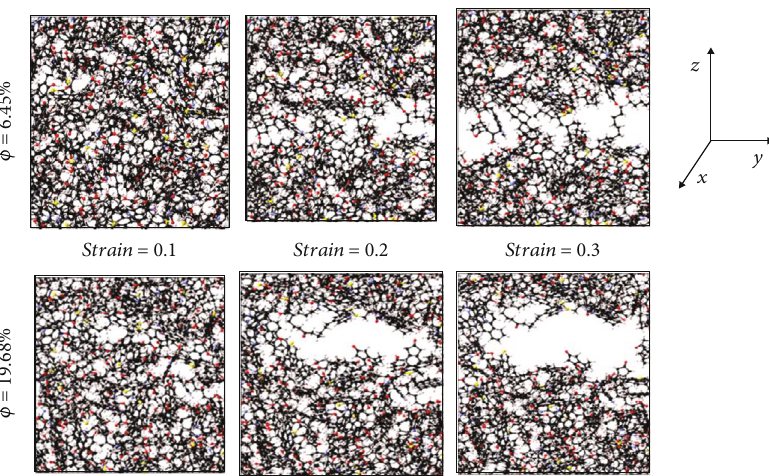
Figure 12: Visualization of the evolution of tensile deformation for two kerogen structures. The fi rst had a porosity of 6.45% and the second of 19.68%.